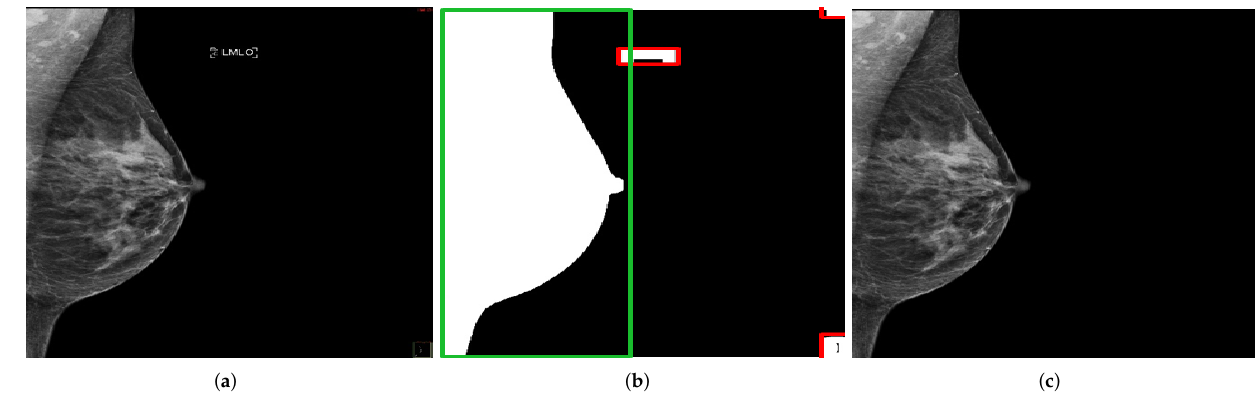
Figure 11. Recognition and removal of all irrelevant information. Green box with the detected chest area and red boxes with all irrelevant detected objects. ( a ) Original MLO view; ( b ) dilation image and objects recognition; ( c ) generated mammogram showing only the breast area.